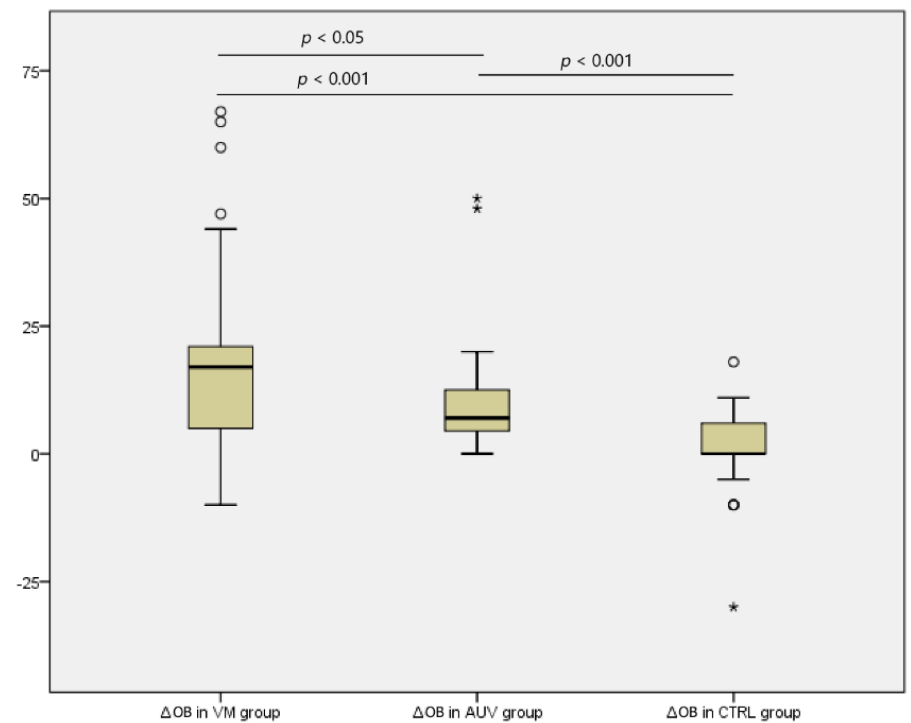
Figure 3. Boxplot showing the ∆ OB values (the absolute value of the difference in the errors with and without optokinetic background, OB) in the VM, AUV, and CTRL groups. A statistically significant difference was found between the ∆ OB values in the VM and CTRL groups ( p < 0.001), the ∆ OB values in the AUV and CTRL groups ( p < 0.001), and the ∆ OB values in the VM and AUV groups ( p < 0.05). * = Extreme values outliers, considering a step of 1.5 × IQR (Interquartile range). Regarding the reported SVQ scores, the mean score for the VM group was 40.36 (ranging from 21.0 to 61.0); in the AUV group, the mean score was 38.35 (from 28.0 to 53.0); while in the control group, the mean score was 5.25 (from 0.0 to 12.0). The differ- ence between groups was statistically significant ( p < 0.001). A significant difference was found between the SVQ scores for the VM and AUV patients and those for the control group ( p < 0.001 and p < 0.001, respectively). On the other hand, no significant differ- ence was found between the VM and AUV groups regarding SVQ scores ( p = 0.530) (Figure 4). The SVQ results were significantly correlated with groups (Spearman’s co- efficient = 0.657, p < 0.001) and significantly negatively correlated with %CA with and without OB (Pearson’s coefficient = − 0.677, p < 0.001 and Pearson’s coefficient = − 0.472, p < 0.001,